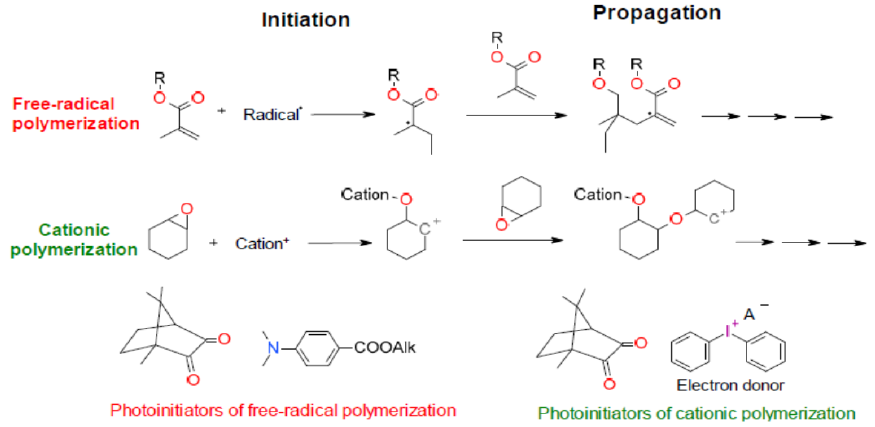
Figure 14. Mechanism of radical and cationic photopolymerisation [113].